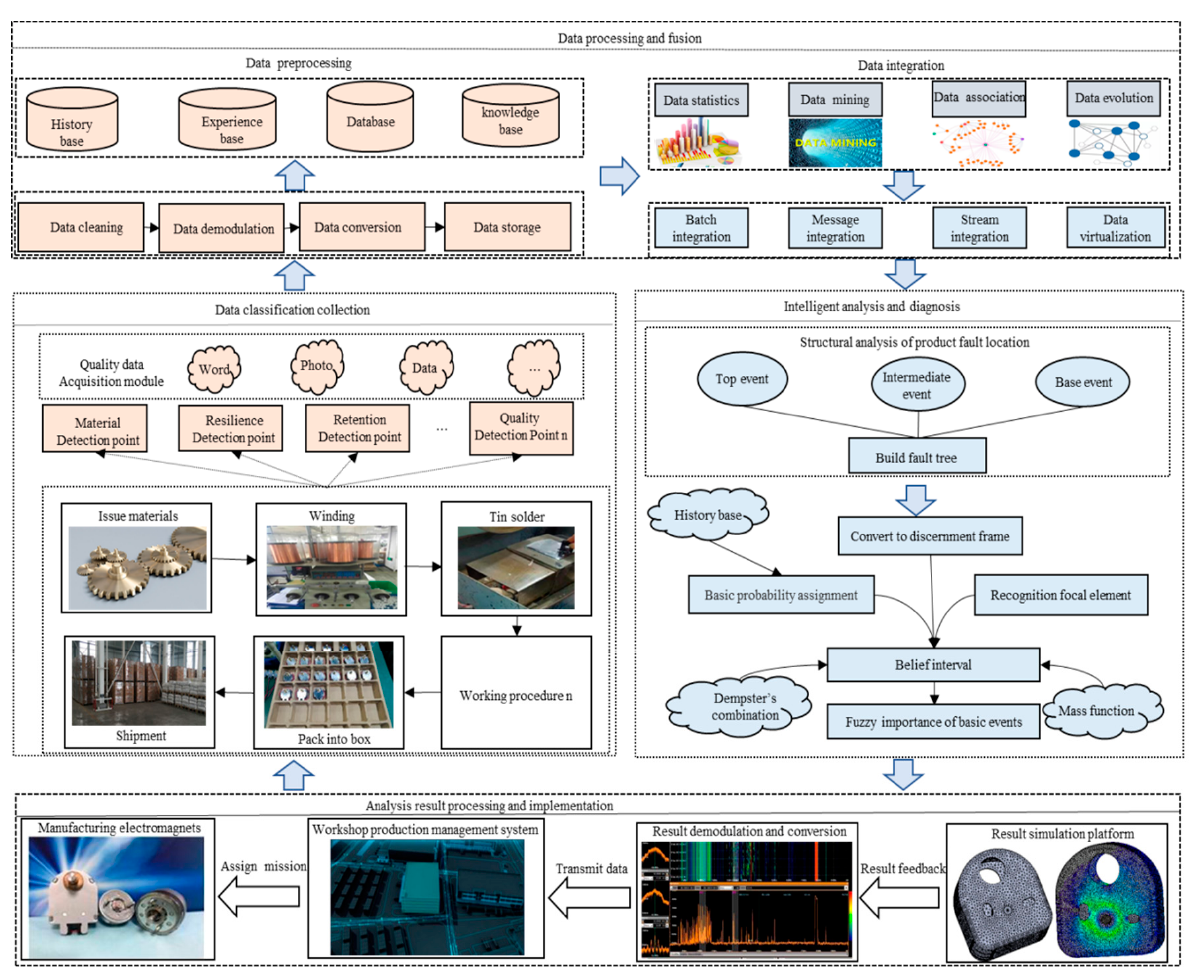
Figure 1. Framework and function of fault intelligent diagnosis system in electromagnet manufacturing process.